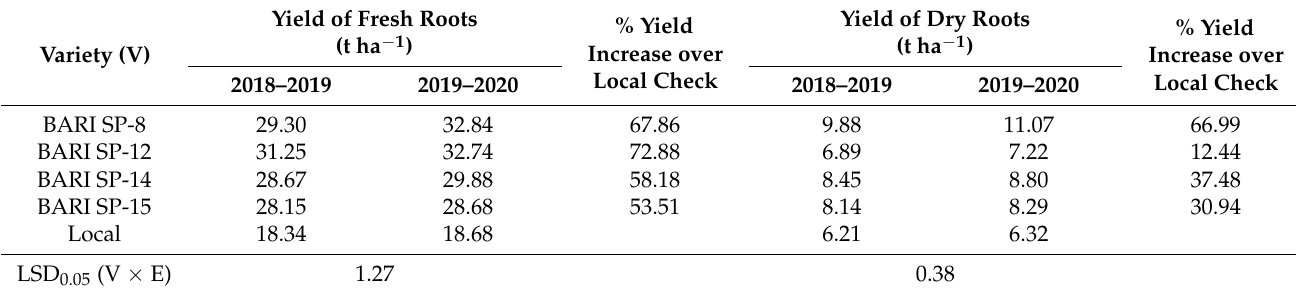
V, Variety, E, Environment (locations) and Y, Year; LSD 0.05 means significant at 5% level of